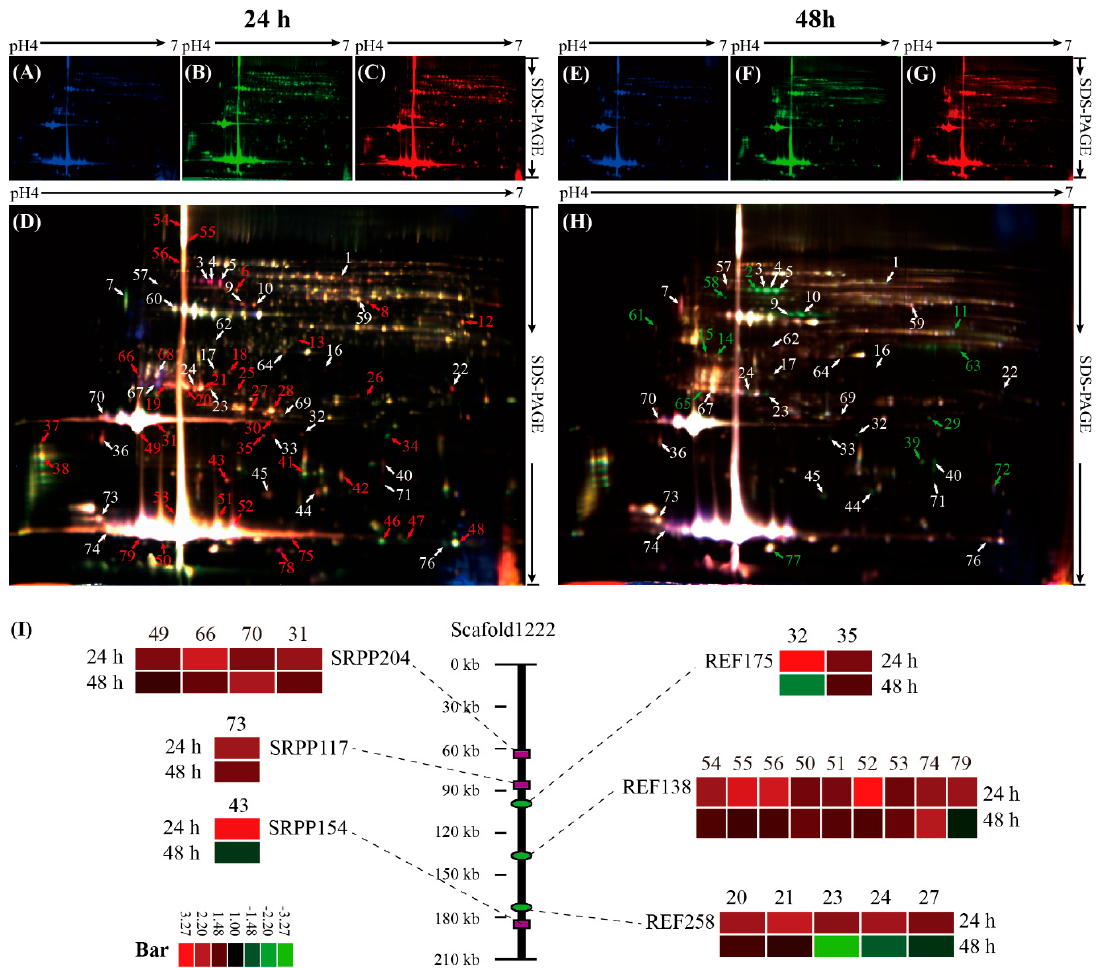
Figure 2. Di ff erential in-gel electrophoresis (DIGE) analysis of SRP proteins upon ethylene stimulation. Internal standards (IS) for protein mixtures are labeled with Cy2 and shown in blue color ( A , E ); Cy3, green, for D24 ( B ) and D48 ( F ); Cy5, red, for E24 ( C ) and E48 ( G ). The combined images of D24, E24, and IS ( D ), and IS with D48 and E48 ( H ) are highlighted. The 79 DAPs (from D1 to D79) are numbered in di ff erent colors (red, up-regulated; green, down-regulated) and their identifications are listed in supplemental Figure S2 and Table S1. The sca ff old locus and changed patterns of the rubber elongation factor (REF) and small rubber particle protein (SRPP) family members are presented ( I ).